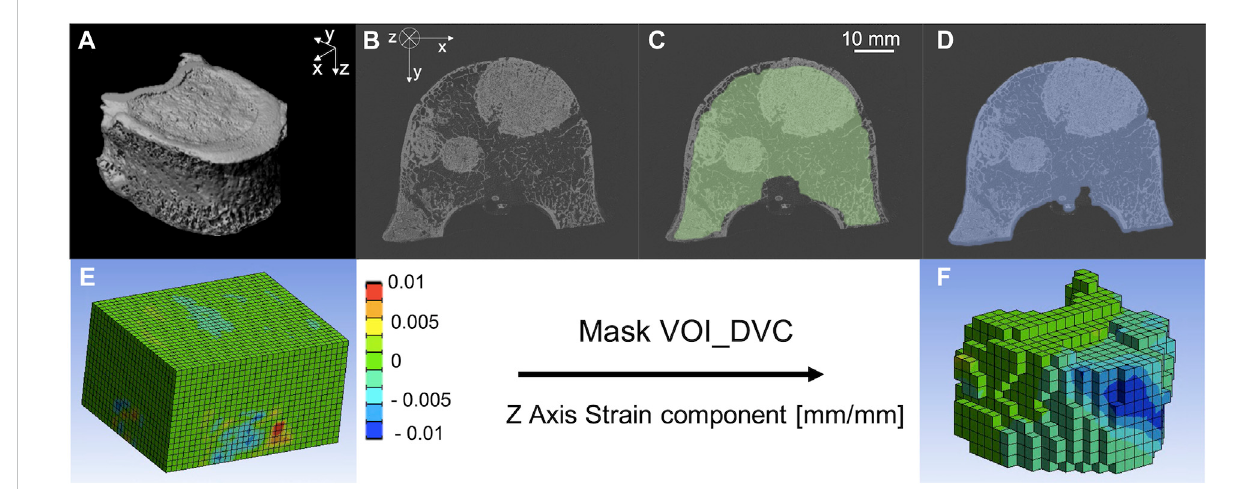
FIGURE 2 (A) microCT of a metastatic vertebra, (B) microCT cross section of a metastatic vertebra, (C) microCT cross section of a metastatic vertebra with superimposed VOI_NoCort mask in green, (D) microCT cross section of a metastatic vertebra with superimposed VOI_DVC mask in blue. Normal component of strain along the cranio-caudal direction (i.e., z — direction) before (E) and after (F) the application of the Mask